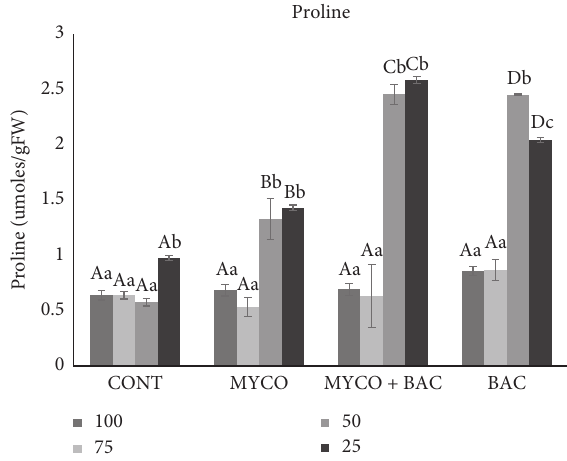
Figure 4: Effect of different water regimes (100%, 75%, 50%, and 25% FC) and mycorrhizal and bacterial inoculation on proline concentration of date palm after 8 months of growth. Vertical bars represent the standard deviation ( n � 3). CONT: control; MYCO: mycorrhizae. Bars with different lowercase letters indicate signif- icant differences between FC at the same treatments ( p < 0 . 05). Bars with different uppercase letters indicate significant differences between treatments at the same FC ( p < 0 . 05).